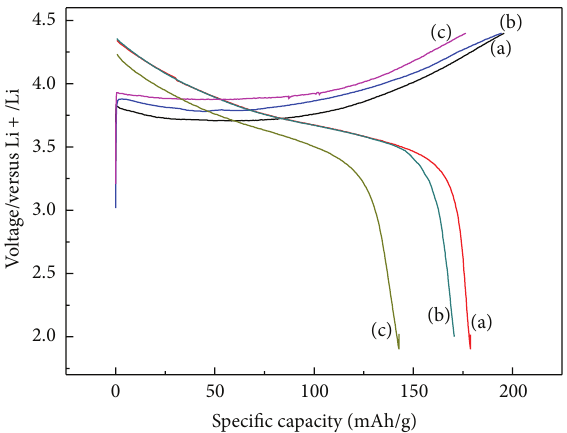
Mg 𝑥 Co 0.3 O 2 – 𝑥 Figure 4: Charge-discharge curves versus cycle number (1st and 20th) of LiNi 0.7 Co 0.3 O 2 at 𝐶/10 rate in the 2.0–4.4 V